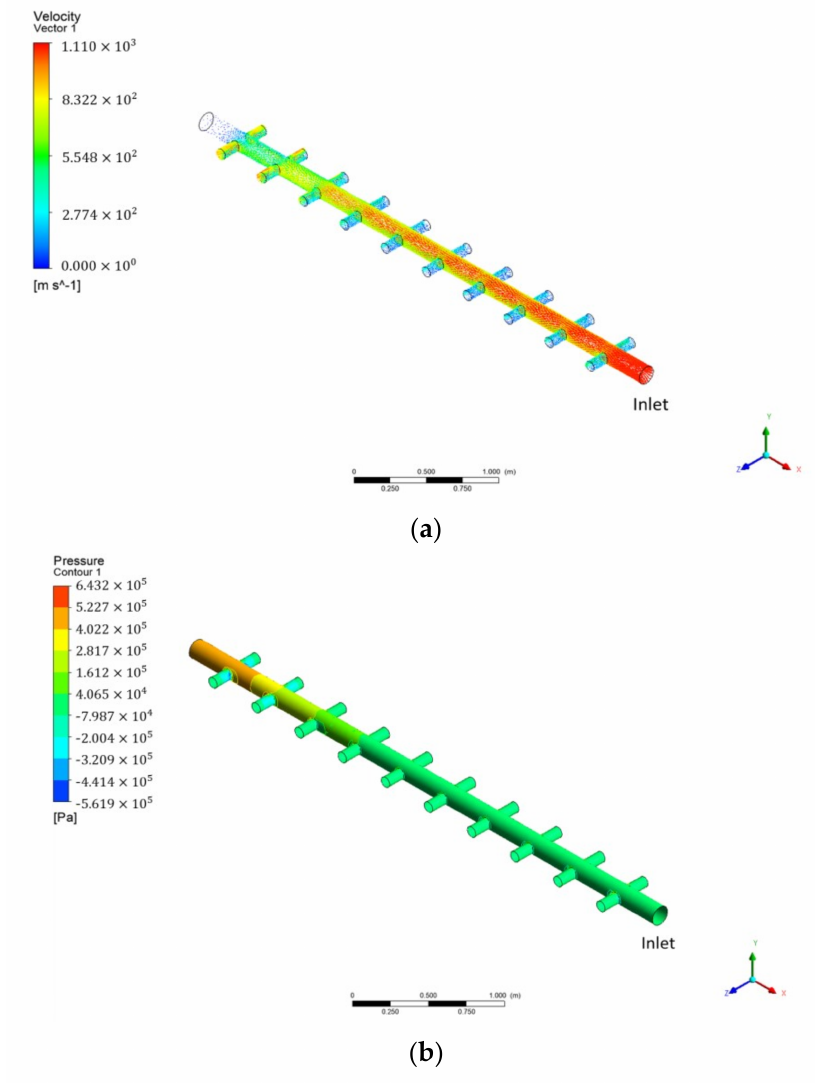
Figure 5. CFD simulation results for existing manifold pipe: ( a ) velocity vector; ( b ) pressure distribu- tion